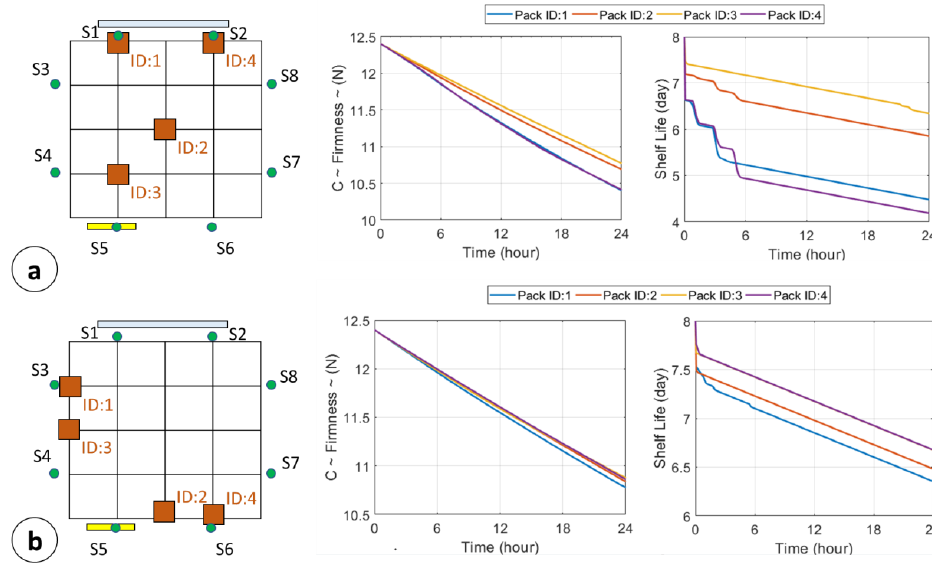
Figure 12. Shelflife Optimization: ( a ) Initial position of the four pallets, firmness decay and SL prediction along the 24 h; ( b ) Final position of the four pallets, firmness decay and SL prediction along the 24 h.